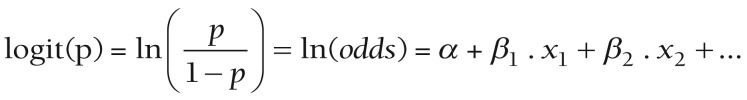
PRISMA study selection flow diagram.